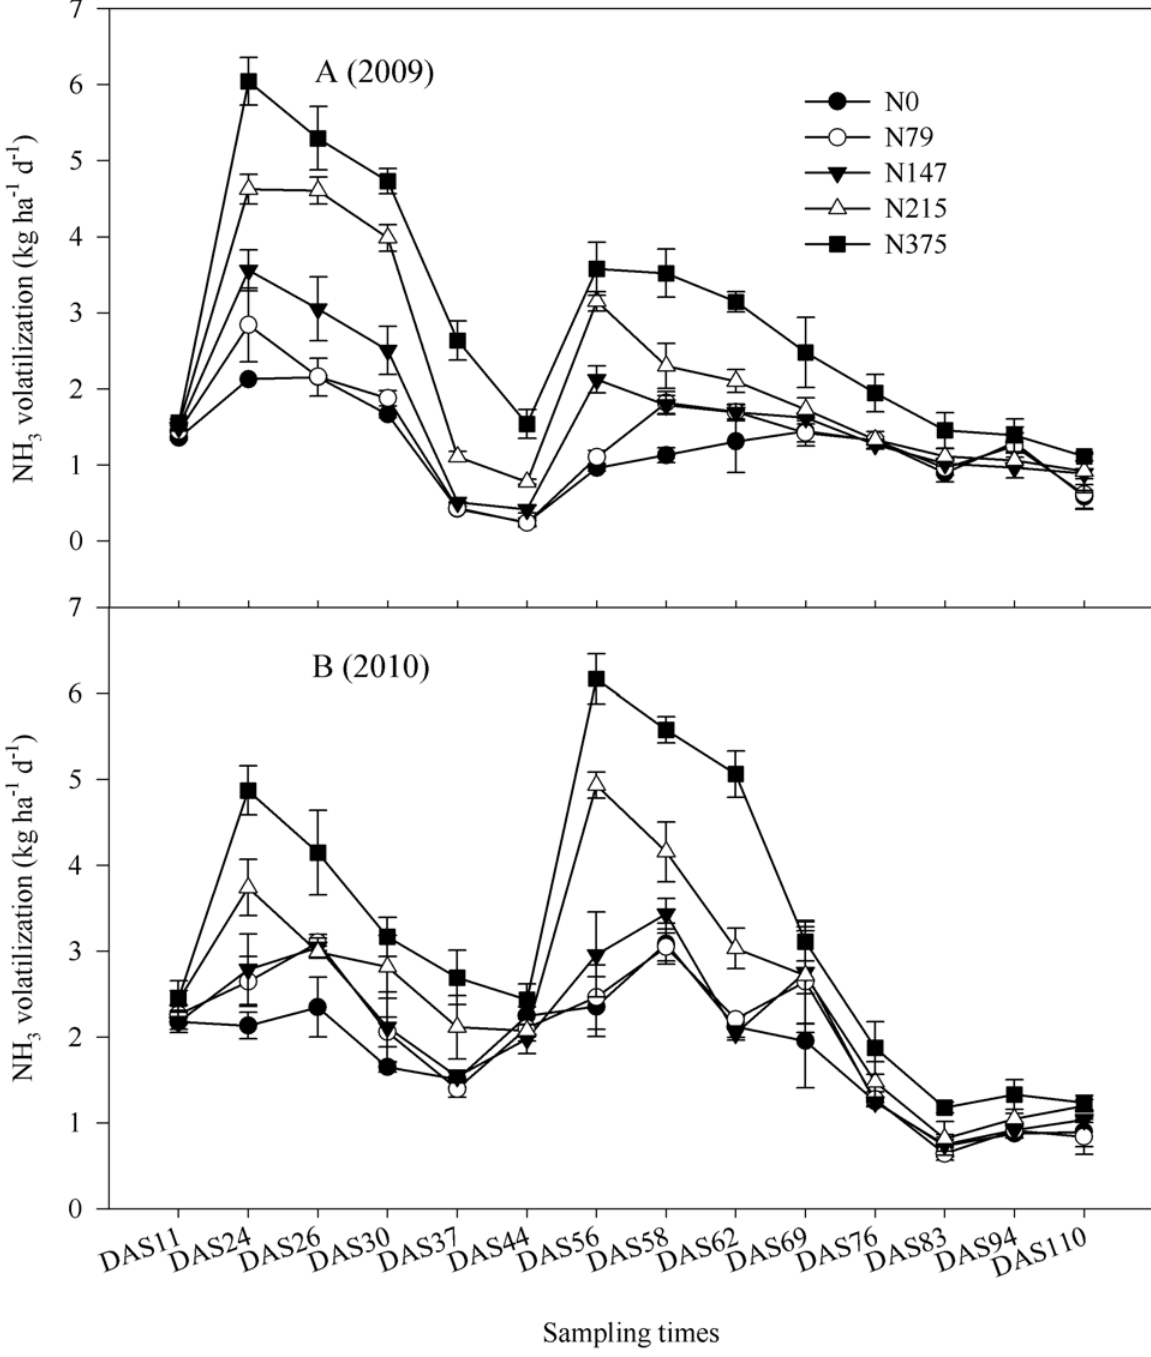
Fig 5. Ammonia volatilization (kg N ha – 1 d – 1 ) in five N fertilizer treatments at different days after sowing (DAS) during maize growth periods (June.12 — Sep.29) in 2009 and 2010. The N fertilizer was incorporated to the soil at V6 stage (Days after sowing 23: DAS23) and R1 stage (Days after sowing 55: DAS55). Each point is the mean of 4 replicated plots. Error bars represent ± SE.